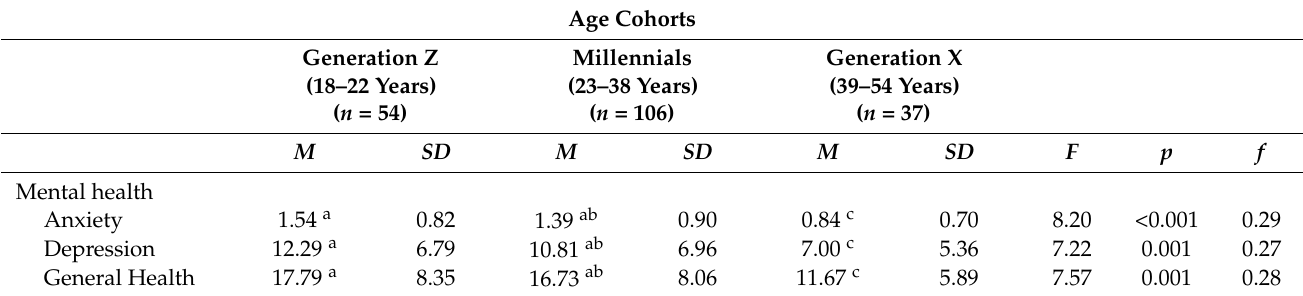
Table 5. Associations between mental health and generational cohorts.